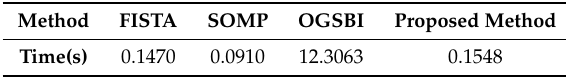
Table 2. Simulation